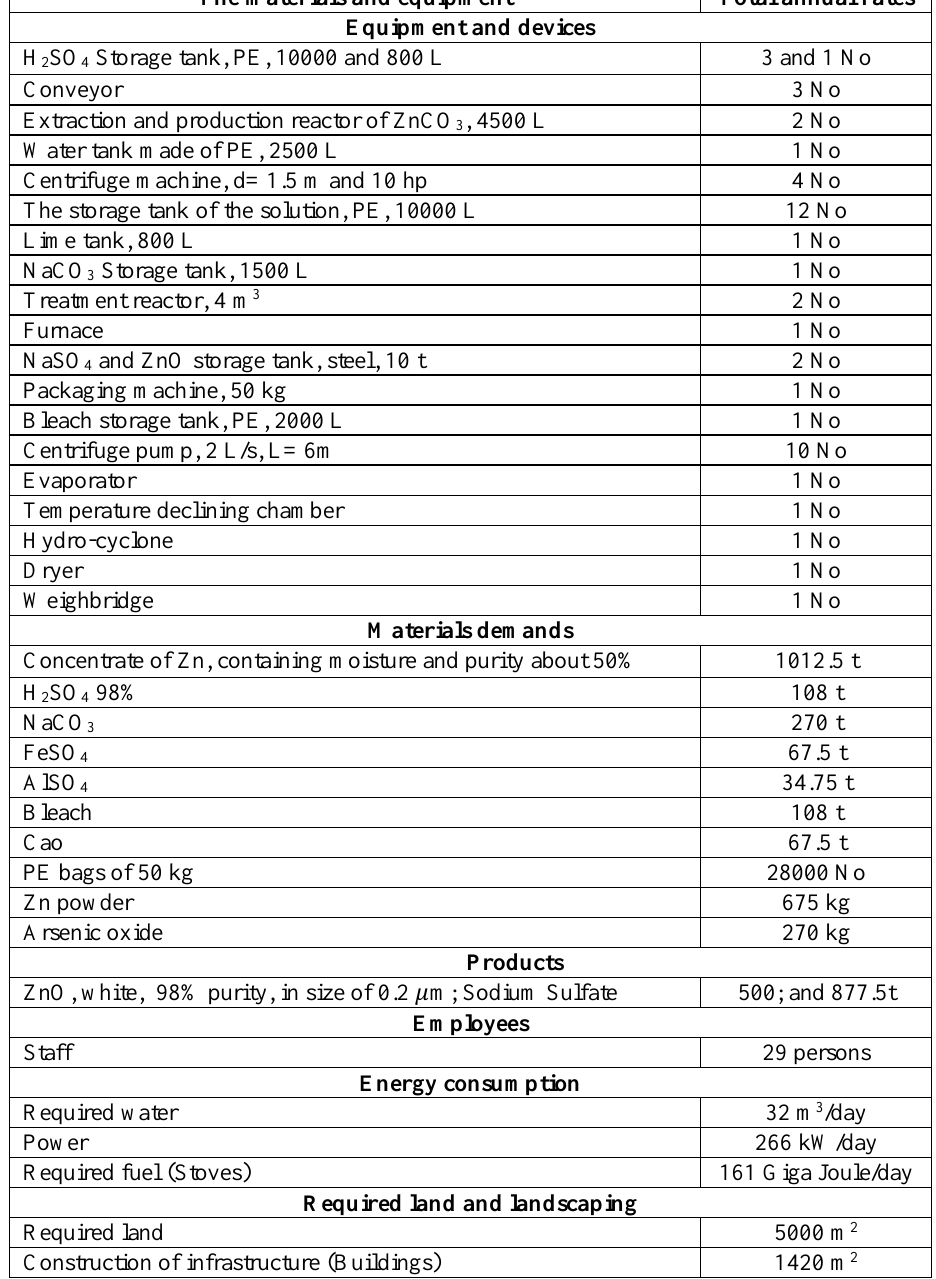
Table 5: The annual requirements of industries of ZnO generation (nominal capacity of 500; and 877.5 tones). The materials and equipment Total annual rates Equipment and